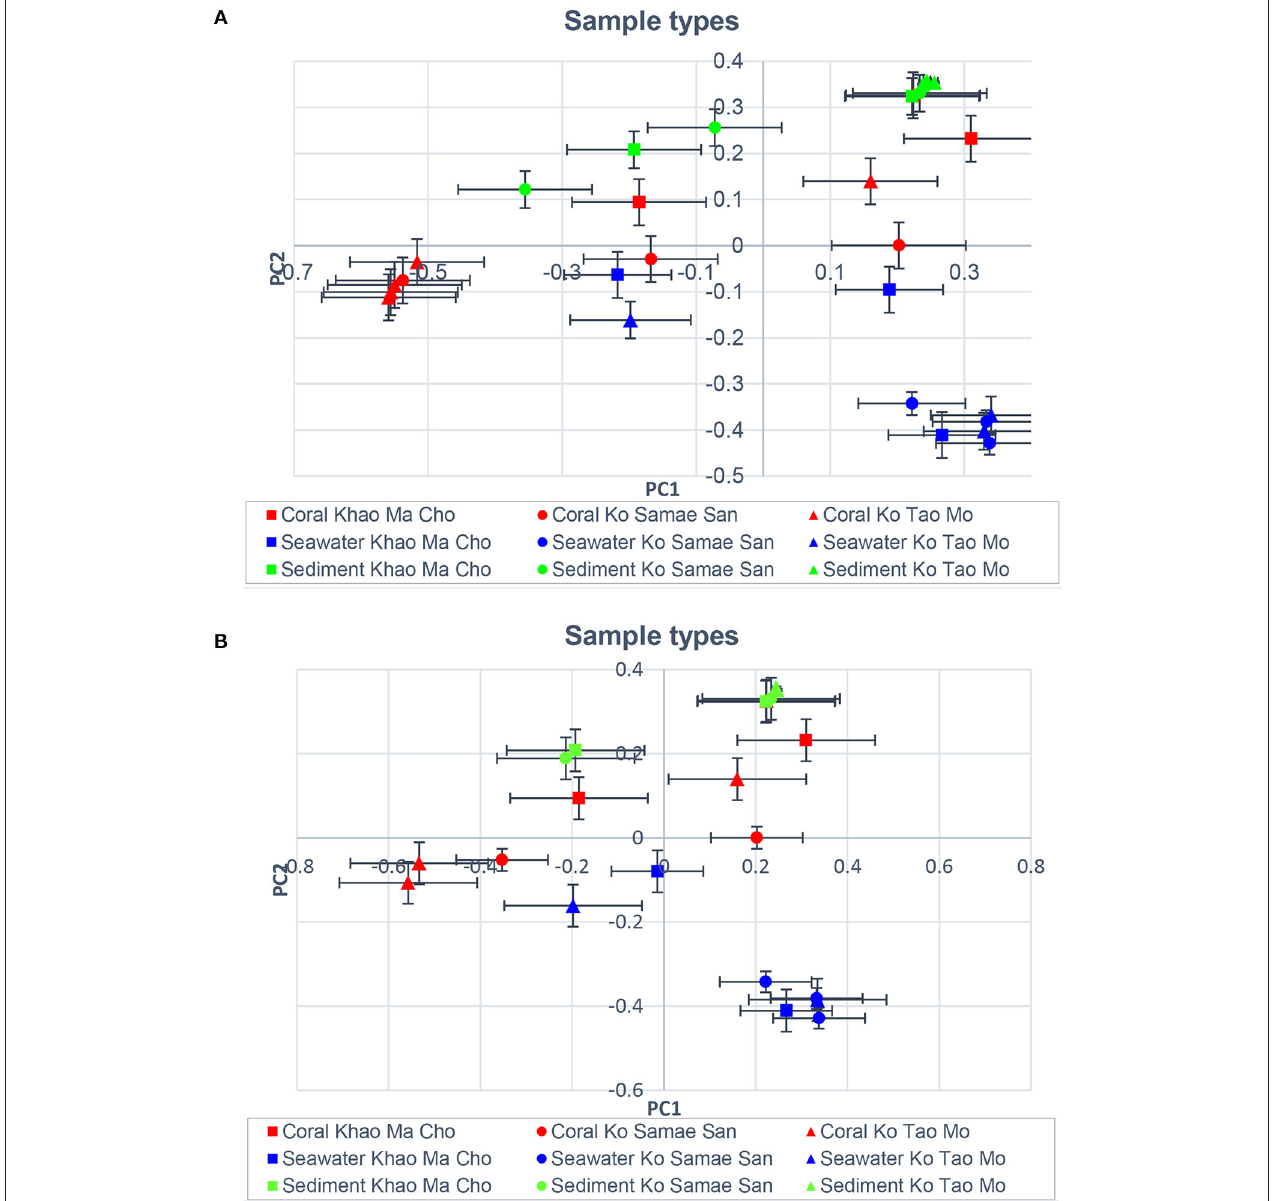
FIGURE 4 | Principal coordinates analysis showing community relatedness for the same sample types, displaying (A) all B-RISA subgroups, and (B) merged subgroups with p >